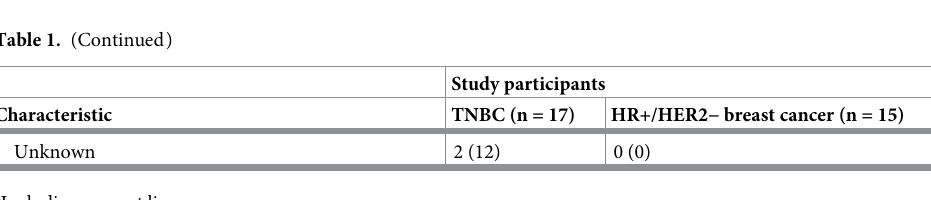
fluctuations) emerged and, therefore, saturation was not fully reached; however, these new symptom concepts were deemed uncommon and no further interviews were completed. Of the 12 most salient symptoms identified across both patient groups (Table 2), fatigue/ tiredness and pain were the most bothersome symptoms for 97% and 72% of all participants, respectively (average bother rating 8), followed by difficulty concentrating, hot flashes (espe- cially in HR+/HER2 − breast cancer group), memory loss, nausea, and sleep problems (average bother rating 7 for all). Pain, including bone pain and/or muscle and joint pain, was reported by 59% of participants with TNBC and 87% of those with HR+/HER2 − breast cancer.